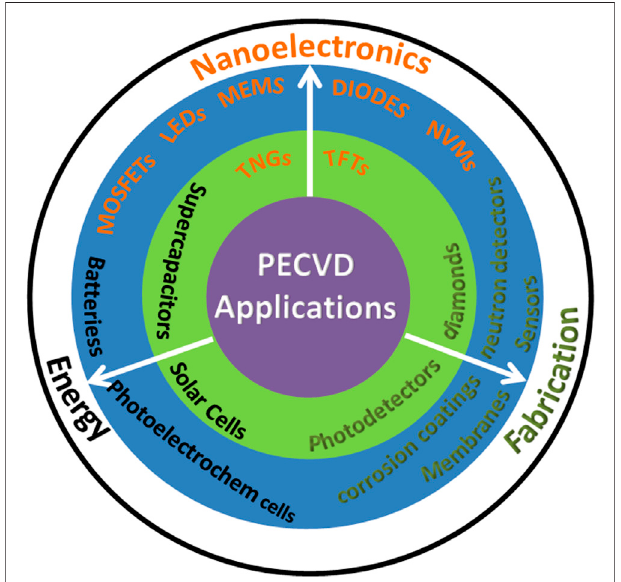
FIGURE 6 | Various applications of